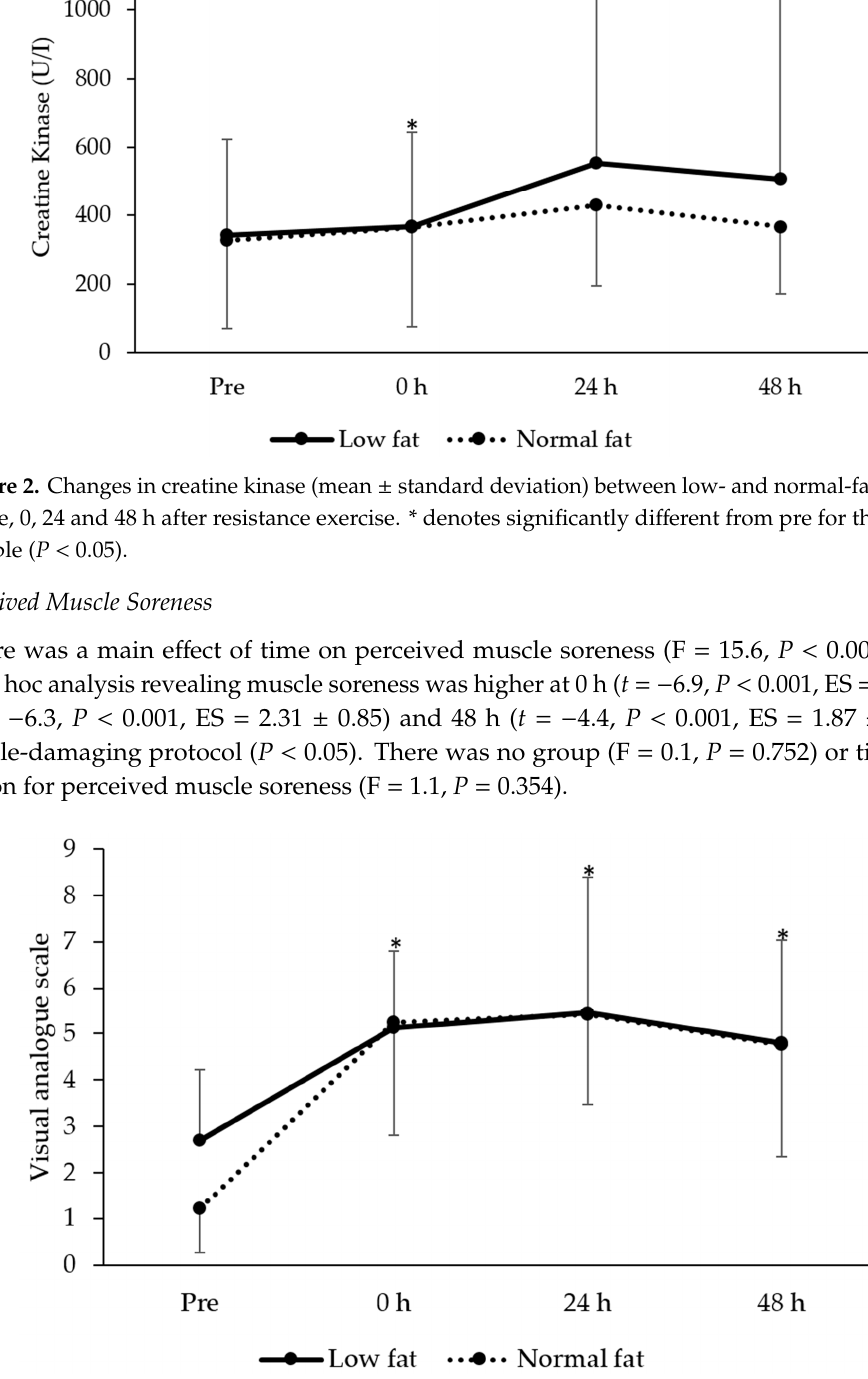
Figure 3. Changes in perceived muscle soreness (mean ± standard deviation) between low- and normal-fat groups at pre, 0, 24 and 48 h after resistance exercise. * denotes significantly different from pre for the whole sample ( P < 0.05).